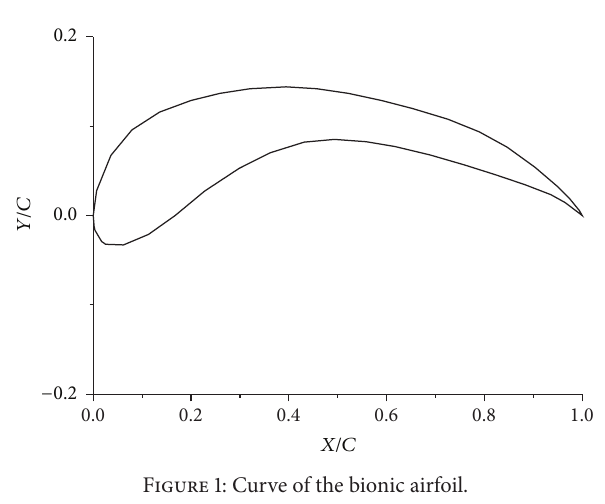
Figure 1: Curve of the bionic airfoil.